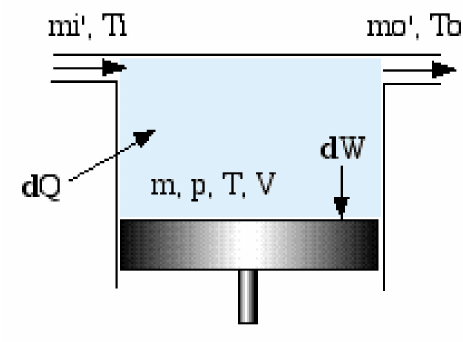
Figure 6. Generic cell diagram of the